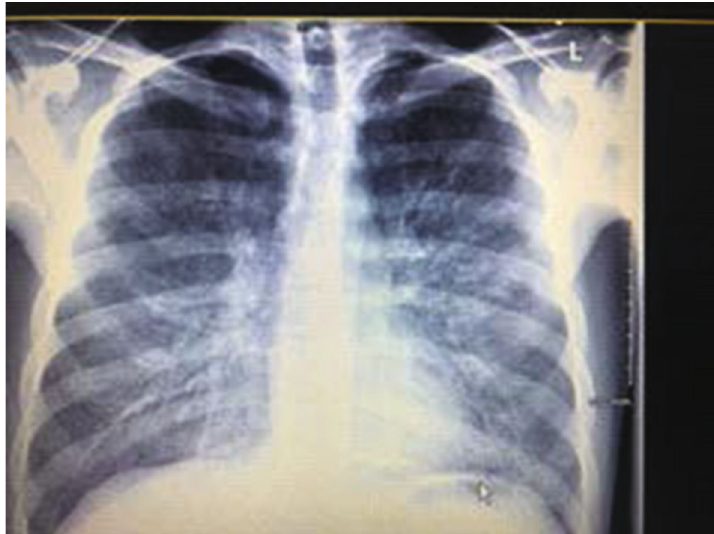
Figure 3: Improvement of pneumomediastinum and subcutaneous